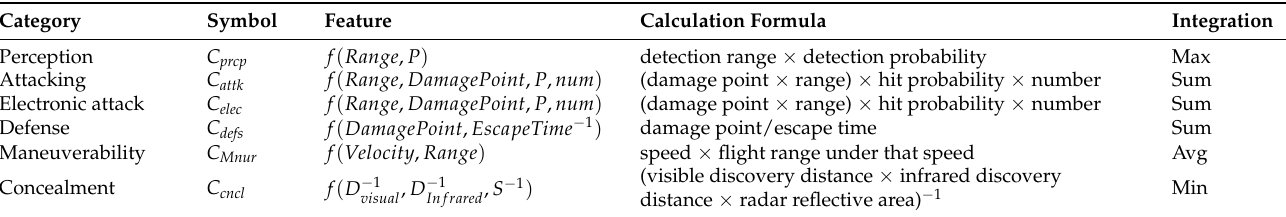
Table 3. Capability feature